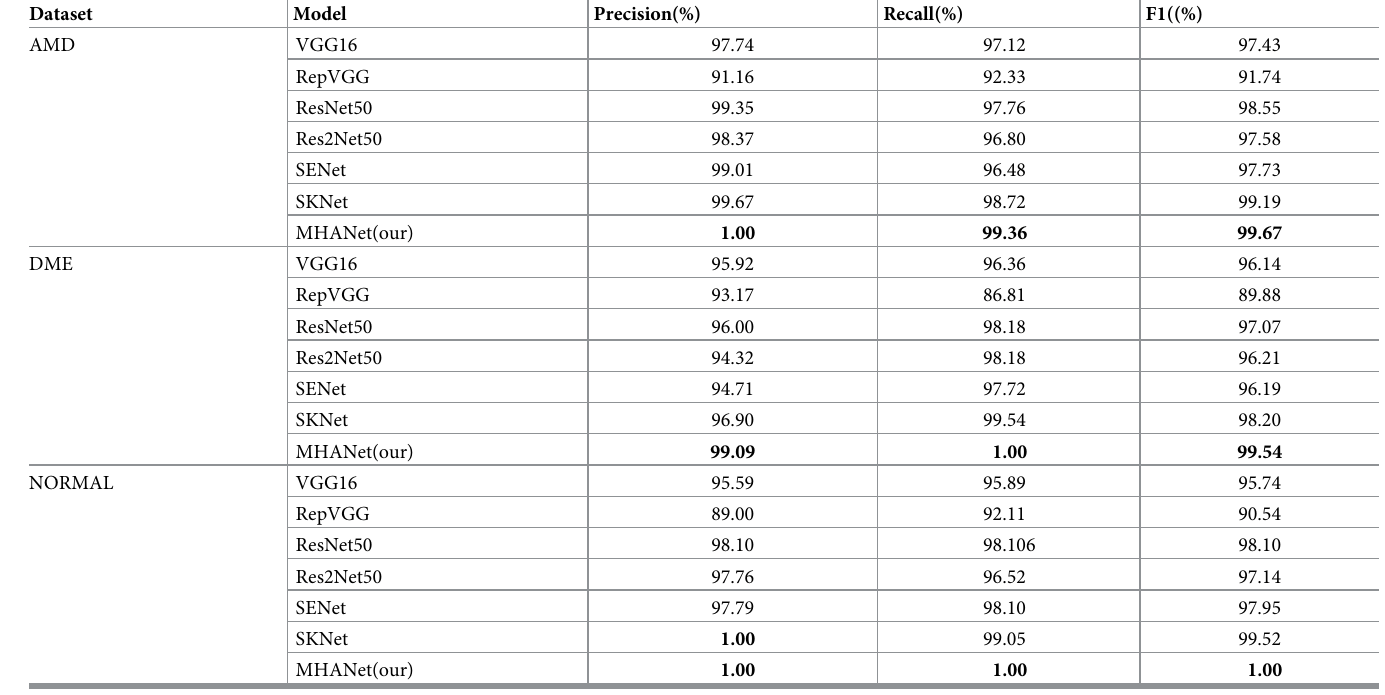
Table 4. Precision, Recall, F1 of